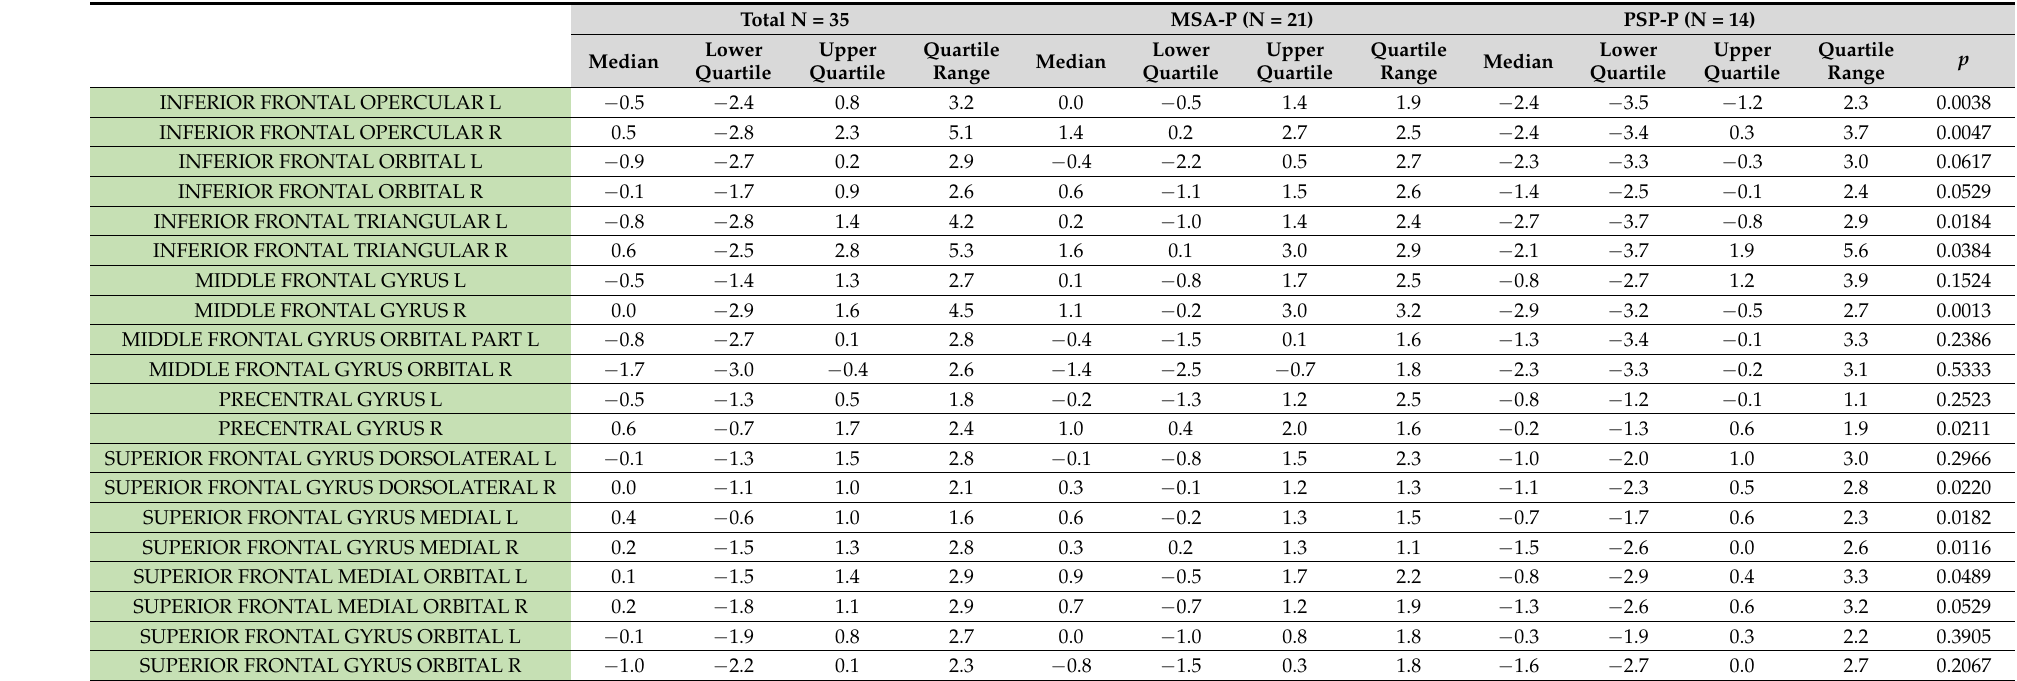
Table 1. Descriptive statistics and group